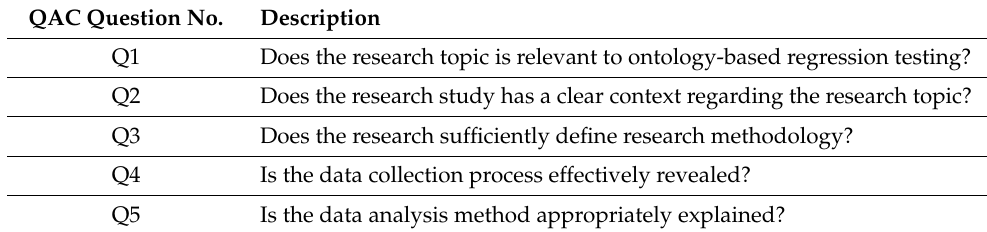
Table 4. Quality assessment criteria and proposed